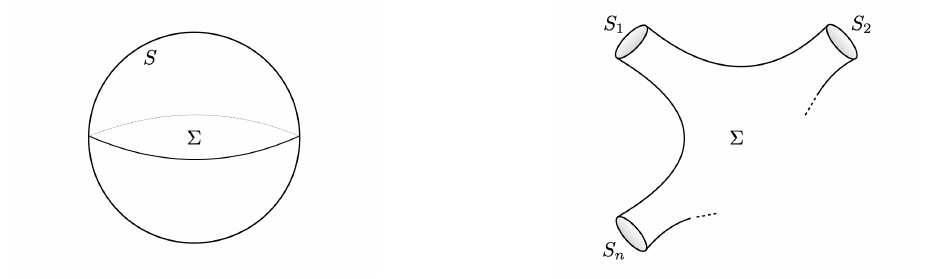
Figure 1. Different topologies of the hypersurface Σ